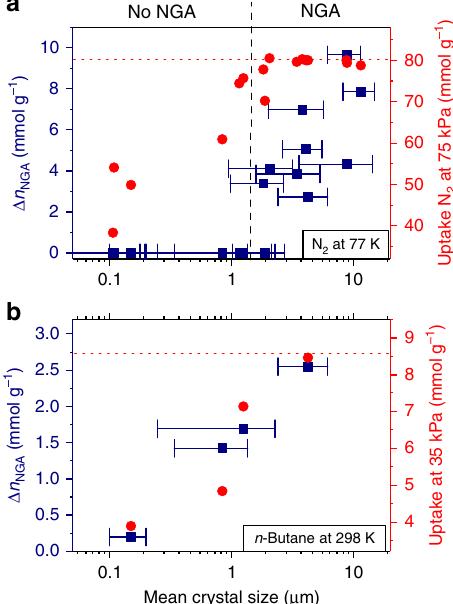
Fig. 3 Relationship between Δ n NGA and crystal size. Semi-logarithmic plot derived from a nitrogen adsorption at 77 K and b n -butane adsorption at 298 K. Values for Δ n NGA are given as blue squares including error bars for crystal size standard deviation, total uptake for nitrogen and n -butane at 75 and 35 kPa, respectively, are given as red circles, and theoretical uptake is given as dotted red